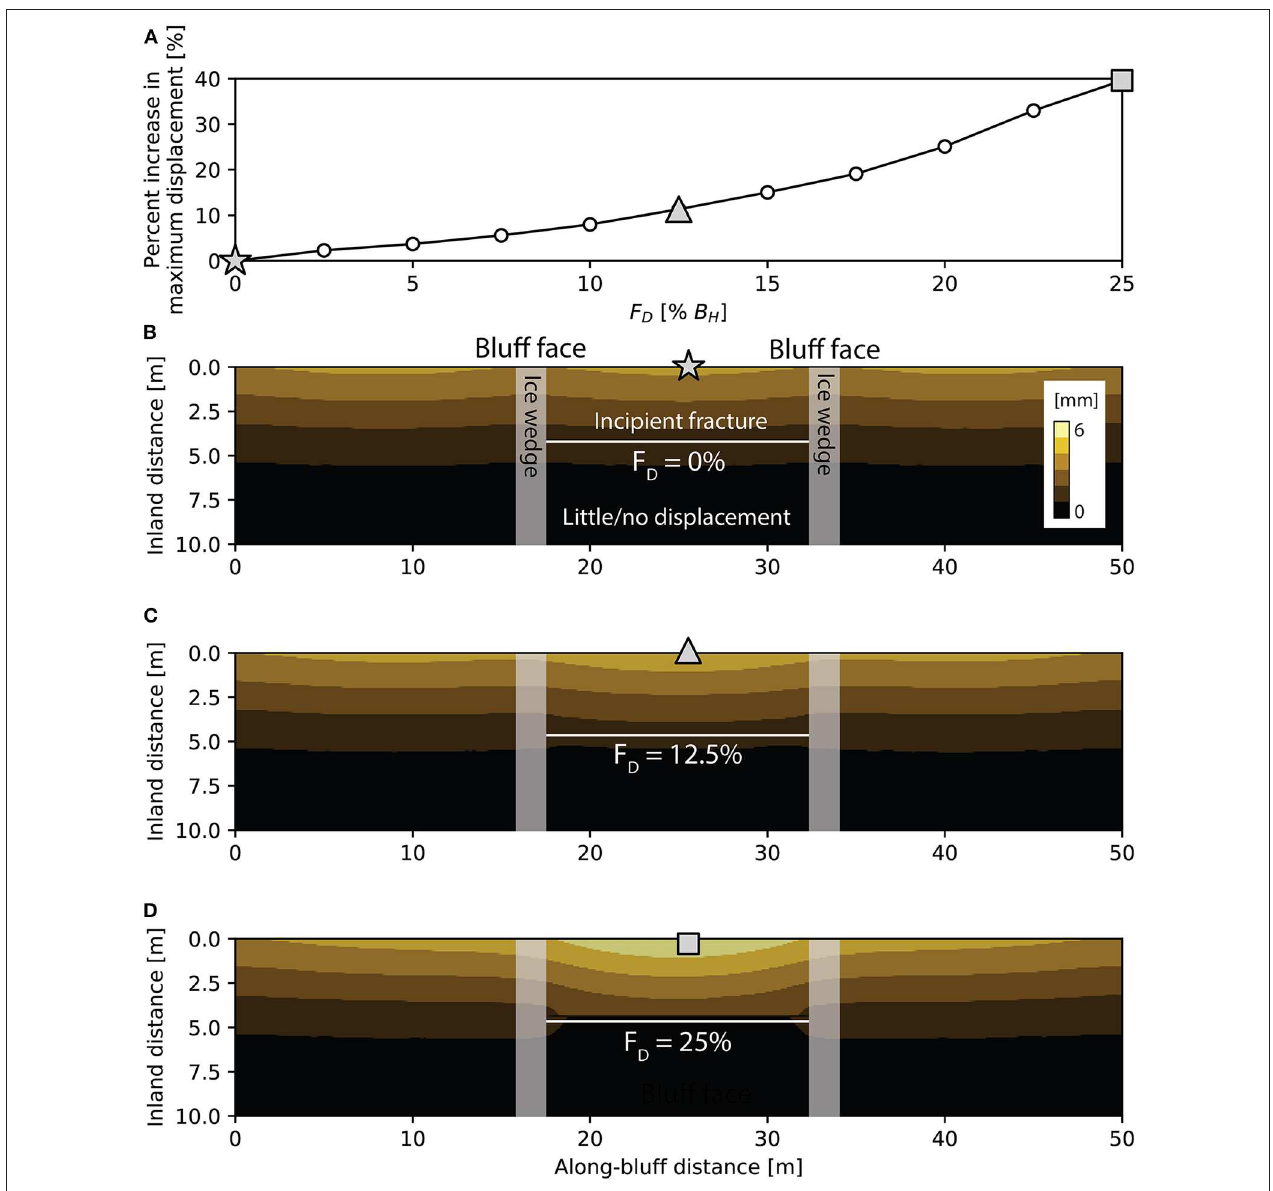
FIGURE 7 | (A) Percent increase in maximum simulated displacement for fracture depth (F D ) scenarios ranging from 0 to 25% of the total (5m) bluff height. The light gray star, triangle, and square symbols correspond to locations in (B–D) , respectively. Plan-view perspective of displacement within the vicinity of a fracture with a F D of (B) 0%, (C) 12.5%, and (D)